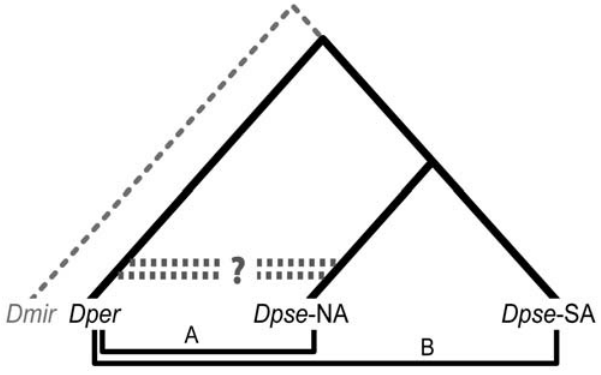
Figure 2. Divergence and gene flow between D.persimilis and D. ps. pseudoobscura . Genic introgression between the two North American sister species, D. persimilis ( Dper ) and D. ps. pseudoobscura ( Dpse -NA), was assayed by comparison to the non-hybridizing isolated South American subspecies, D. ps. bogotana ( Dpse -SA). Recent genic introgression between Dper and Dpse -NA is expected to generate different levels of divergence ( Dper-Dpse -NA , Dper-Dpse -SA) while an absence of gene flow is expected to produce equivalent levels of divergence ( Dper-Dpse -NA= Dper-Dpse -SA). Differences in lineage-spe- cific evolutionary rates were assessed using a nonhybridizing species outgroup, D. miranda ( Dmir ).